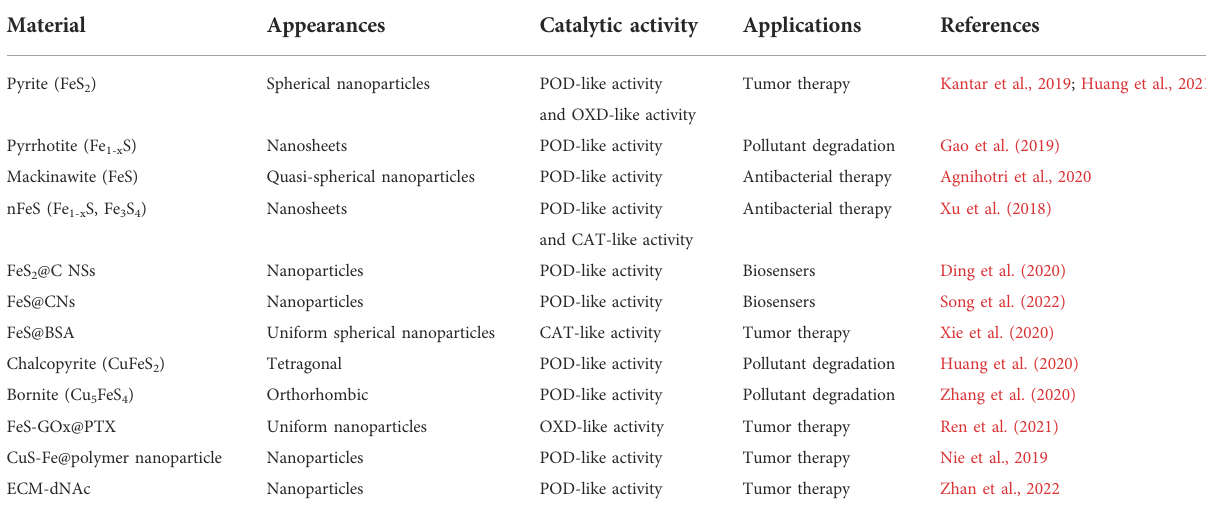
TABLE 1 Catalytic activities of ISNs. Peroxidase, POD; catalase, CAT; oxidase, OXD; FeS 2 @C nanosheets, FeS 2 @C NSs; FeS@carbon nanosheets, FeS@ CNs; glucose oxidase, GOx; paclitaxel, PTX; extracellular matrix-degrading nanoagonist, ECM-dNAc.